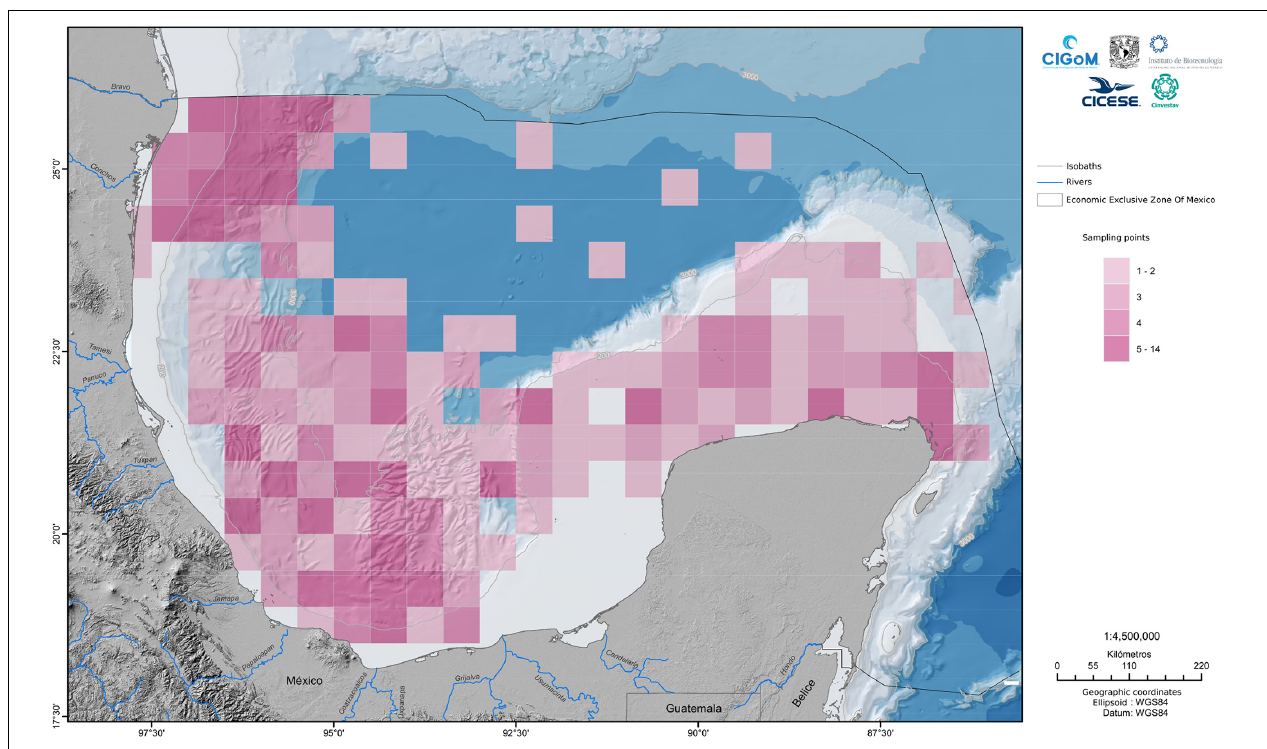
FIGURE 1 | Sampled sites: We illustrated the sample sites of the campaigns performed from March 2015 to September 2017. The data were grouped in a grid, in cells of 0.5 degrees of latitude × 0.5 degrees of longitude.